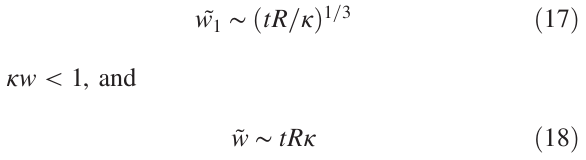
FIG. 4. Faceted stretching-dominated ribbons. (a) Sketch of the locally tubular configuration observed in experiments. (b) Closed ribbons (made here of polypropylene or latex bilayers) exhibit polygonal shapes, the number of sides corresponding to the number of locally tubular portions. When the width is gradually reduced, the number of sides increases. (c) Finite-element simulation of a portion of a curved stretching-dominated ribbon. The color codes for the bending energy density: it increases with the angle θ [as predicted by Eq. (14)], except along the inner boundary. (d) Simulation of full structures, with clear bending energy focusing at the junction between tubular sections. (e) Geometrical rule to predict the typical angle extension θ of the sides and hence the number of sides. (f) Number of c sides n as a function of the slenderness ratio R=w of the curved ribbons. Simulations and experimental data (pictures of some experiments in inset) are quantitatively predicted by the simple geometric construction [Eq.